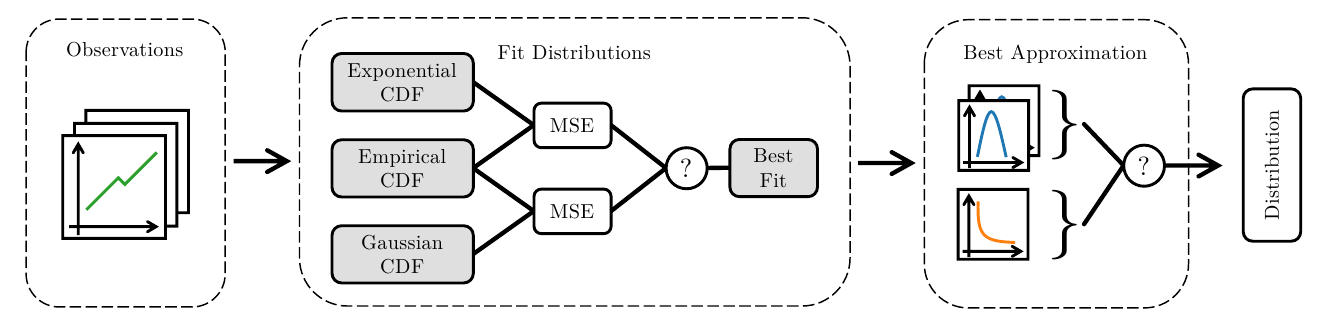
Figure 5. Semi automatic rule definition based on statistical properties of observations and major- ity voting.